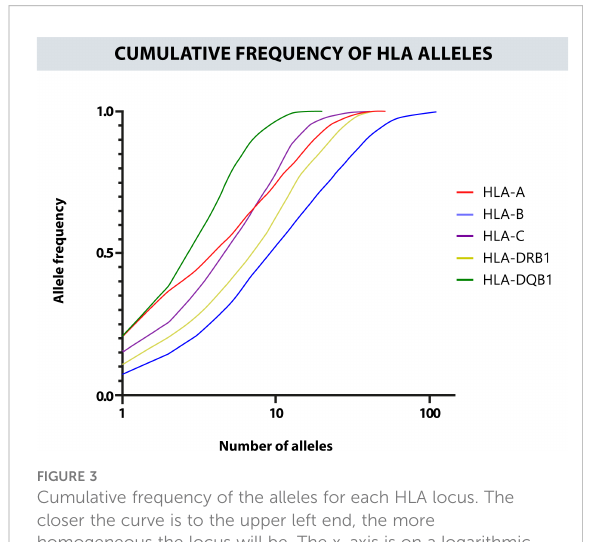
FIGURE 3 Cumulative frequency of the alleles for each HLA locus. The closer the curve is to the upper left end, the more homogeneous the locus will be. The x-axis is on a logarithmic scale. The most polymorphic locus is HLA-B, followed by HLA- DRB1 and HLA-A, and the least polymorphic is